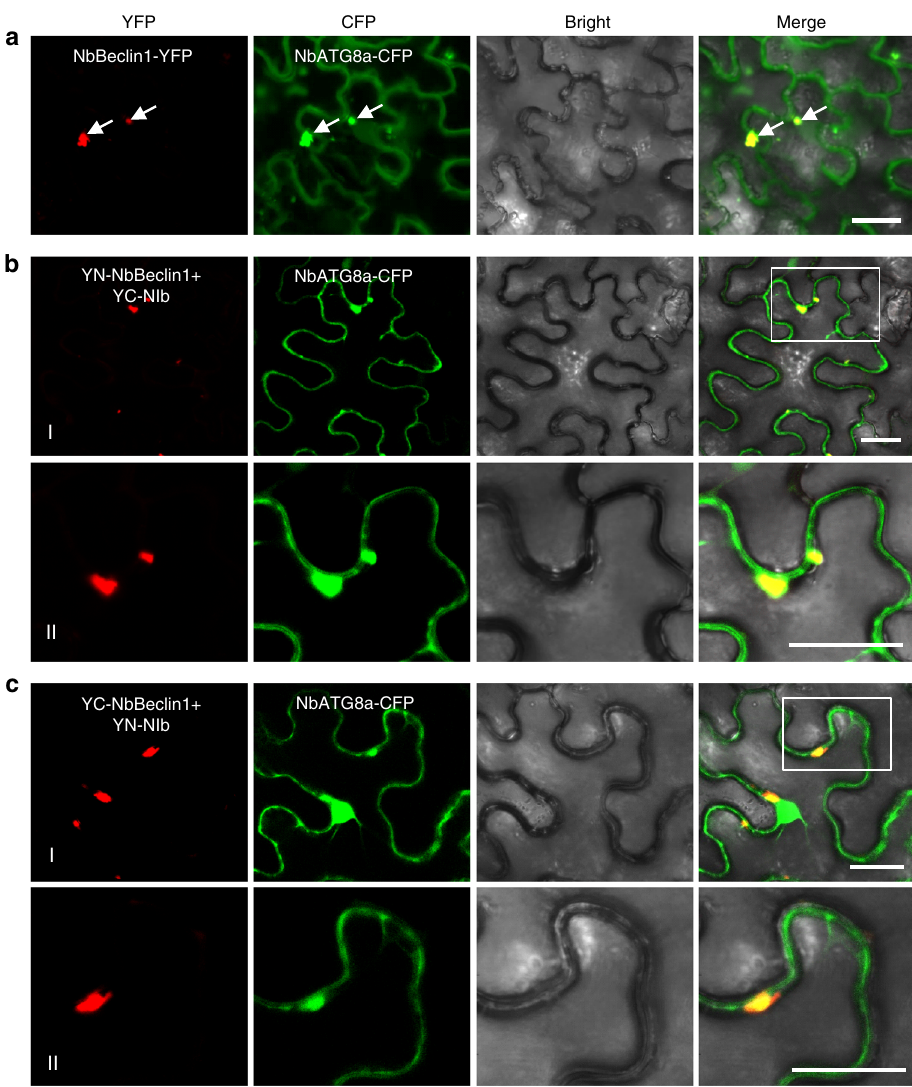
Fig. 3 NbBeclin1 or the NbBeclin1 – NIb interaction complex co-localizes with the autophagosome marker NbATG8a in N . benthamiana . a Transient co- expression of NbBeclin1-YFP and NbATG8a-CFP. Arrows indicate yellow fl uorescence, which resulted from the overlapping of NbBeclin1-YFP (red) and NbATG8a-CFP (green) fl uorescence. b Co-localization of YN-NbBeclin1 and YC-NIb with NbATG8a-CFP. c Co-localization of YC-NbBeclin1 and YN-NIb with NbATG8a-CFP. All confocal micrographs in this fi gure were taken at 48 hpi. The corresponding region in the white box in the panel I of b , c is magni fi ed in panel II. Bars, 25 µ